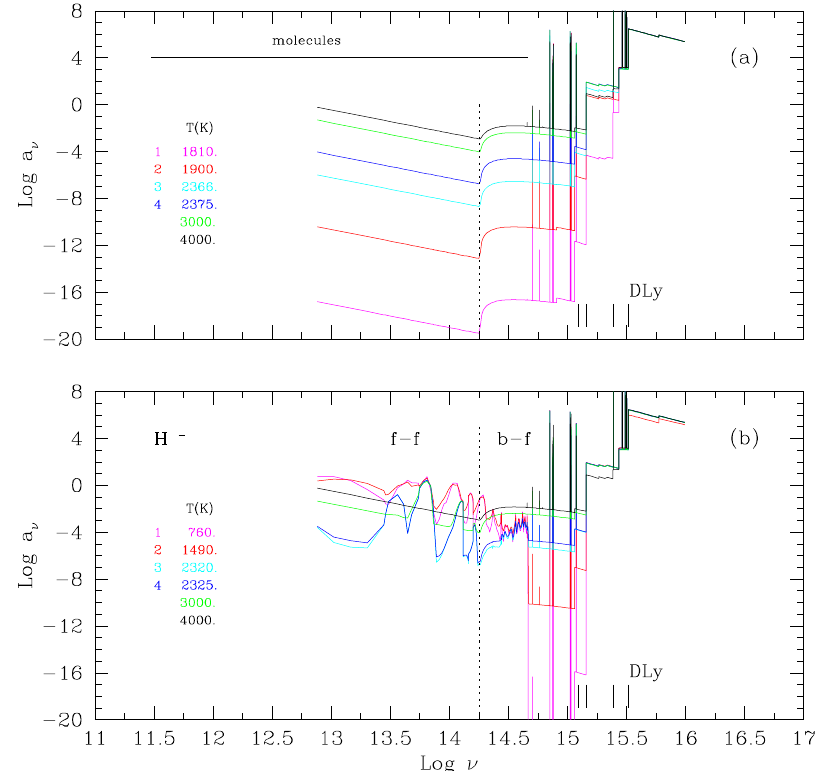
Figure 3. Frequency profile of the absorption coefficient a ν at different temperatures, specified by color according to the key shown. Panel ( a ) without molecules, panel ( b ) with molecules. The absorption coefficients have been computed from the models (a,c) shown in Figure 2. The numbers on the left of the temperatures correspond to the positions marked in panels (a,c) of Figure